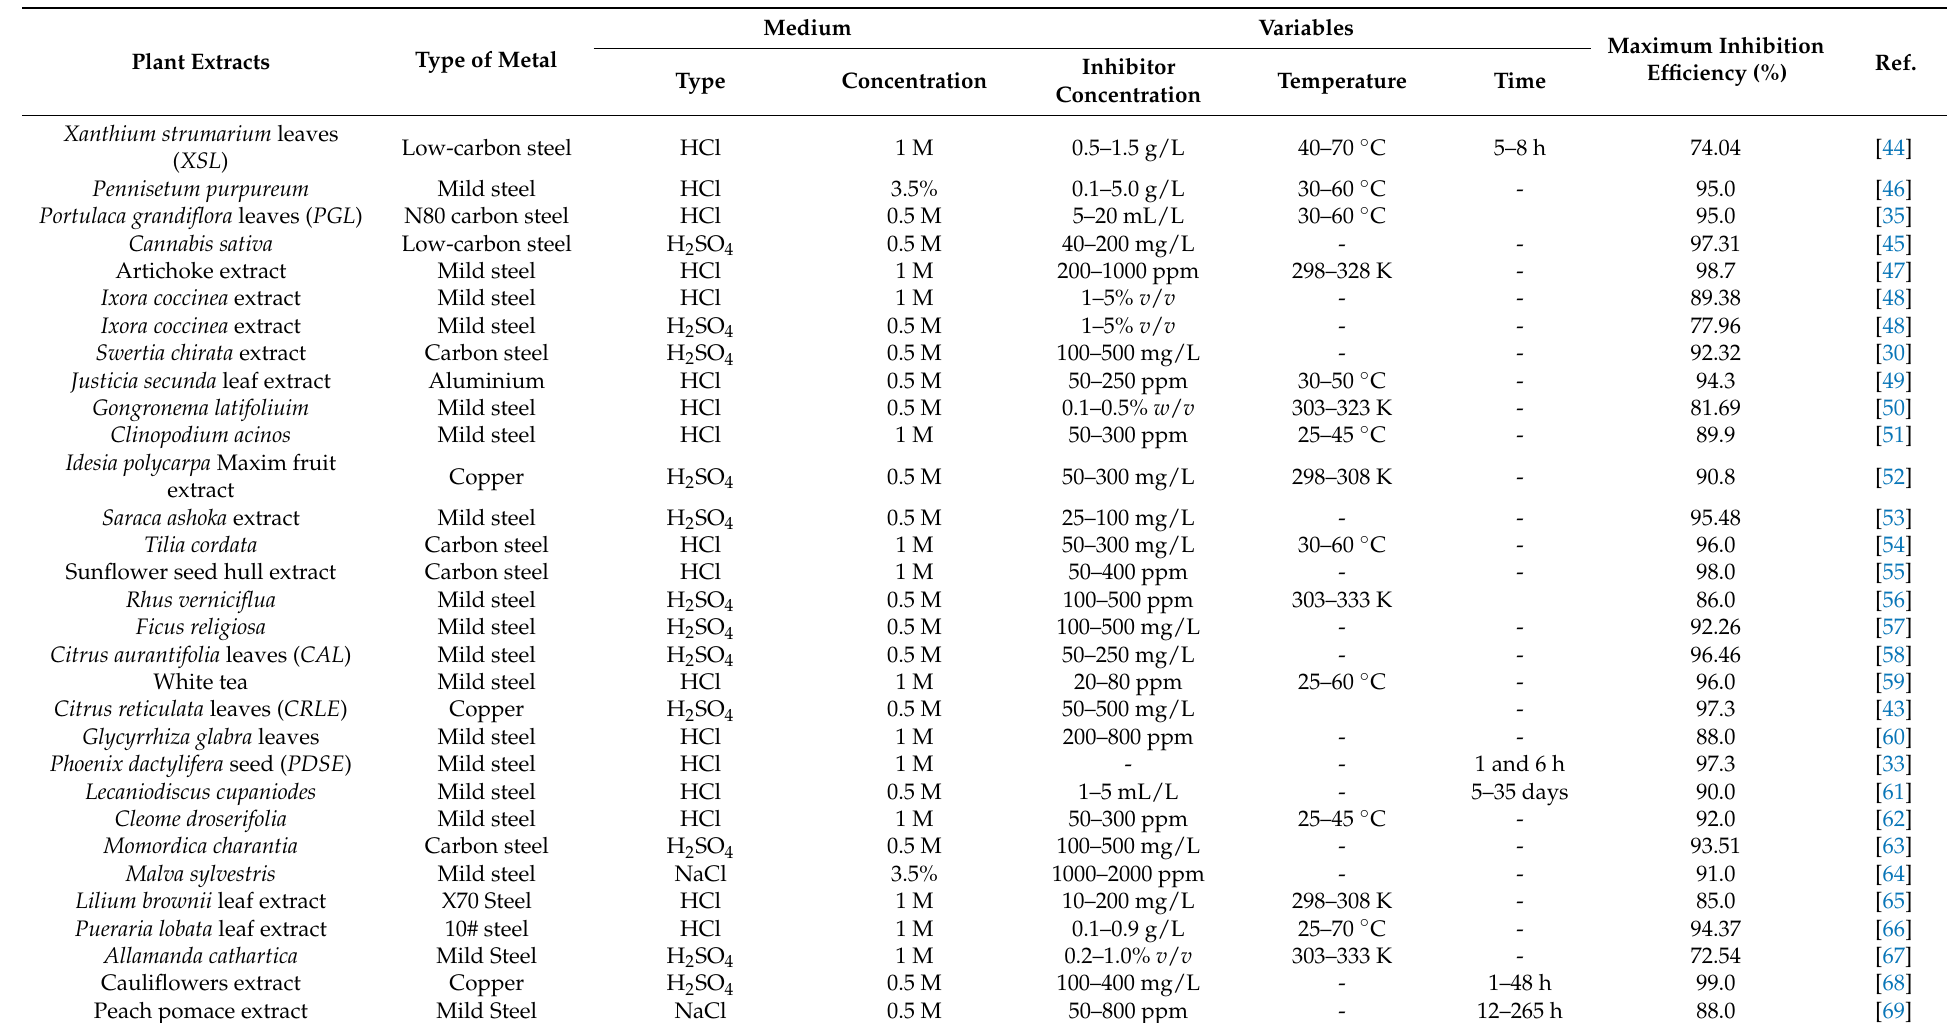
Table 2. Past studies concerning organic corrosion